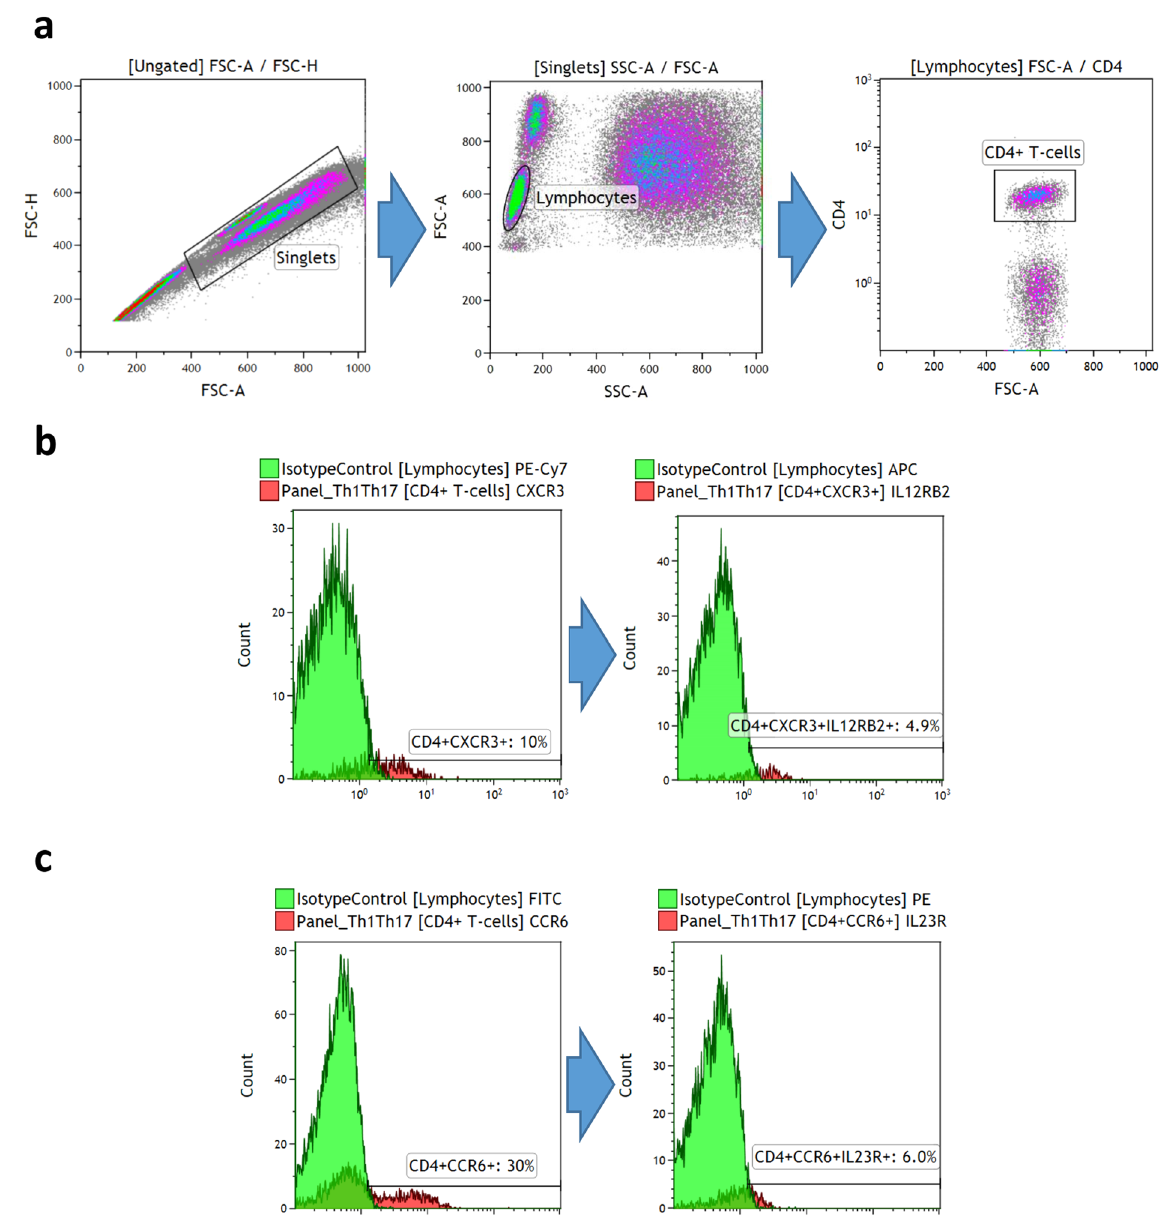
Figure 1. Gating strategies for identifying T helper 1 (Th1) and 17 (Th17) cells using Kaluza Software. ( a ) We first identified CD4 + T-cells by first identifying singlets (using forward height vs. area scatter), then lymphocytes (using forward vs. side scatter), and then the CD4 + lymphocyte population. ( b ) Th1 cells are CD4 + CXCR3 + IL12RB2 + , so we first gated CD4 + and identified CXCR3 + cells, which we then gated to identify the IL2RB2 + cells. We used negative isotype control at 1% to distinguish positive populations from non-specific background signals. ( c ) Th17 cells are CD4 + CCR6 + IL23R + , so we first gated CD4 + and identified CCR6 + cells, which we then gated to identify the IL23R + cells. We used negative isotype control at 1% to distinguish positive populations from non-specific background